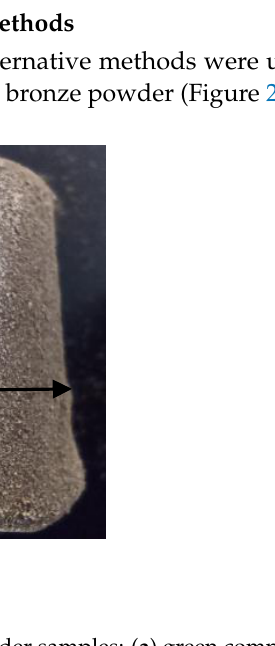
Table 1. Typical Material Properties of MetalFil-Ancient bronze, PLA-based